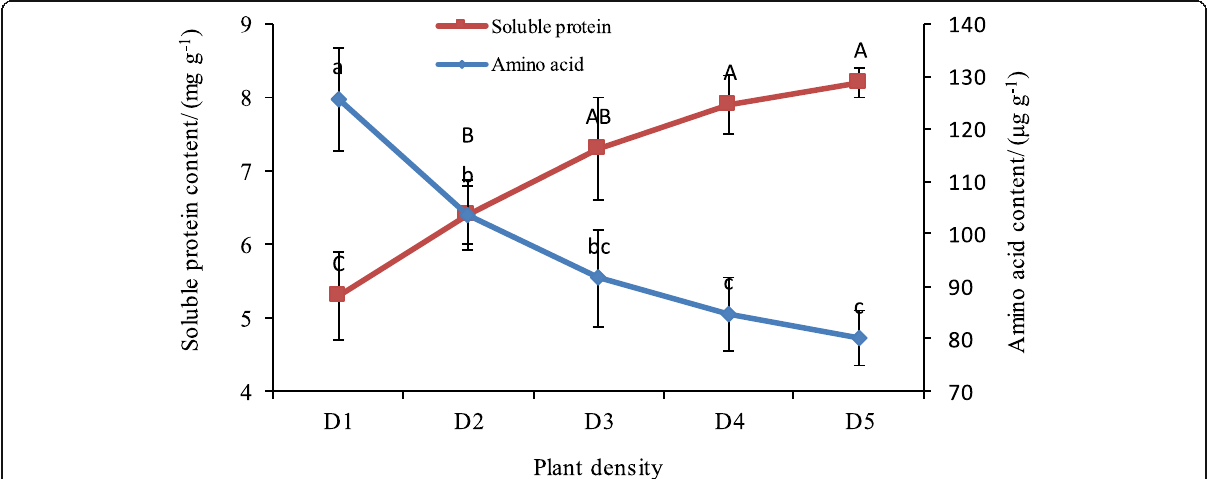
Fig. 1 The amino acid and soluble protein content in boll wall with different planting densities in 2017. D1-D5: 15 000, 25 000, 45 000, 60 000, and 75 000 plants per hectare. The vertical bar represents S.E. of the mean ( n = 3) when the value exceeds the size of the symbol. Lowercase letters indicate significance analysis among amino acids, and capital letters indicate significance analysis among soluble proteins. The same letter among treatments is not significantly different ( P ≥ 0.05)